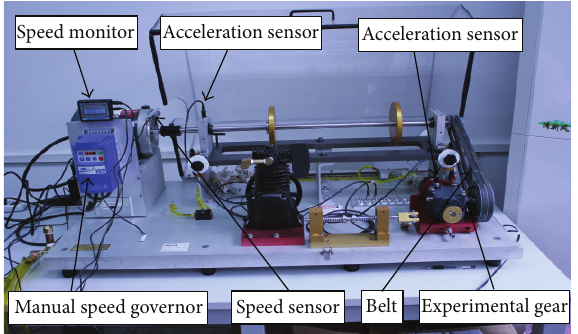
Figure 8: Compound fault of a bearing.